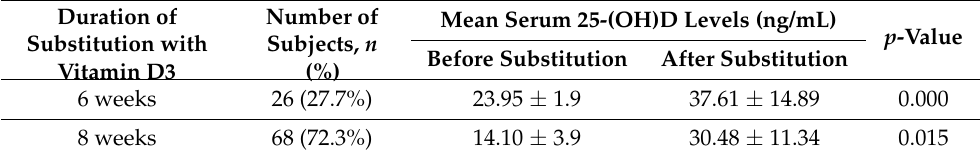
Table 3. Mean serum levels of 25-(OH)D before and after substitution therapy with 4000 IU/day of vitamin D3 during 6 and 8 weeks,